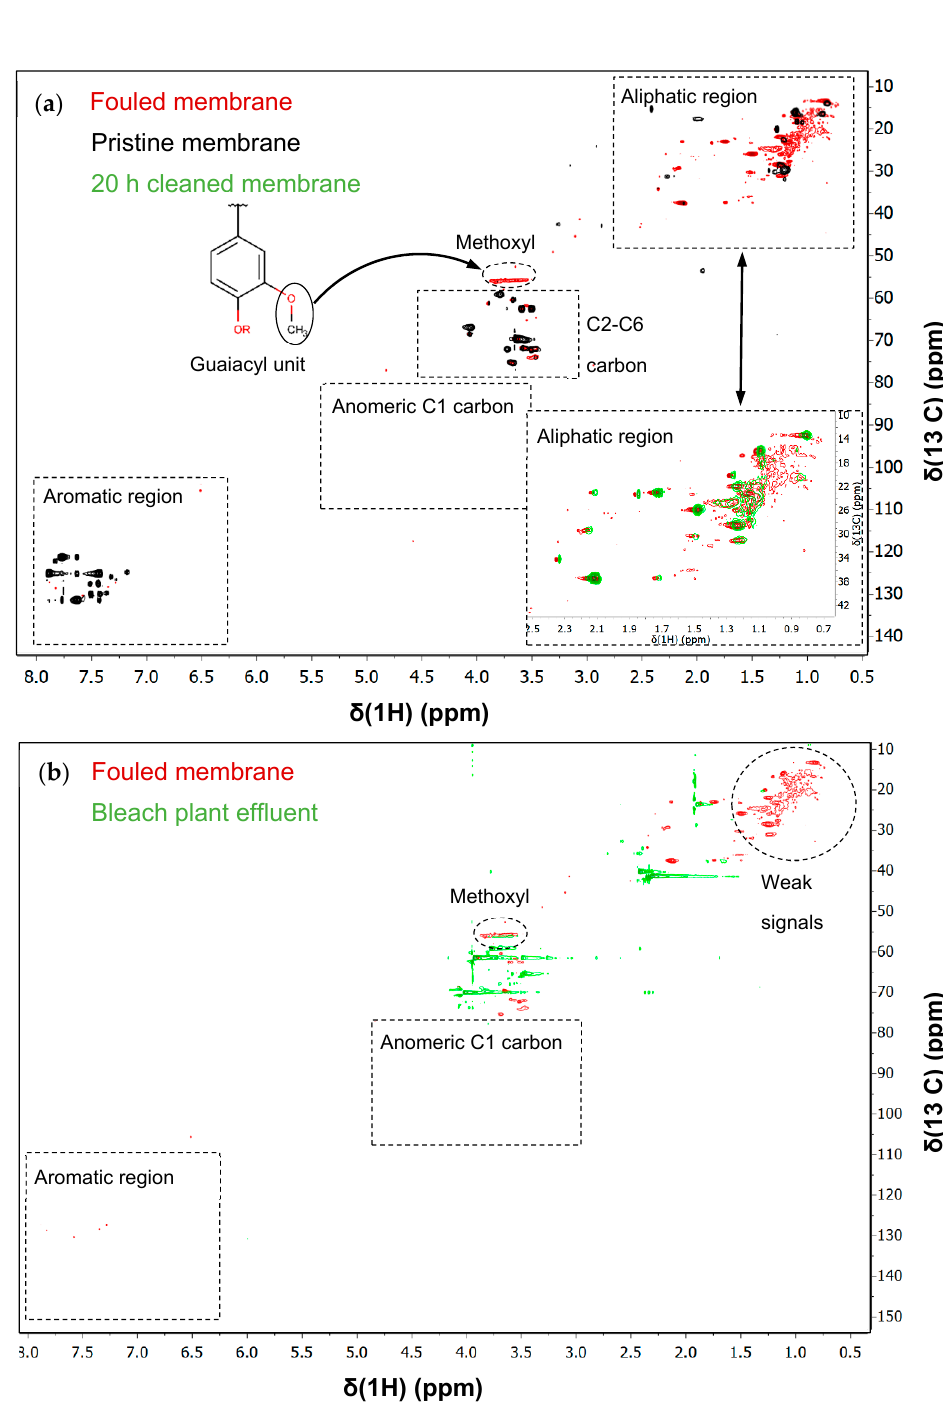
Figure 10. Results of heteronuclear single quantum coherence 2D nuclear magnetic resonance (HSQC-2D-NMR) measurements on: ( a ) the fouled membrane ( red ), the pristine membrane ( black ), and the membrane cleaned for 20 h ( green ), and on ( b ) the fouled membrane ( red ) and the bleach plant effluent ( green ).